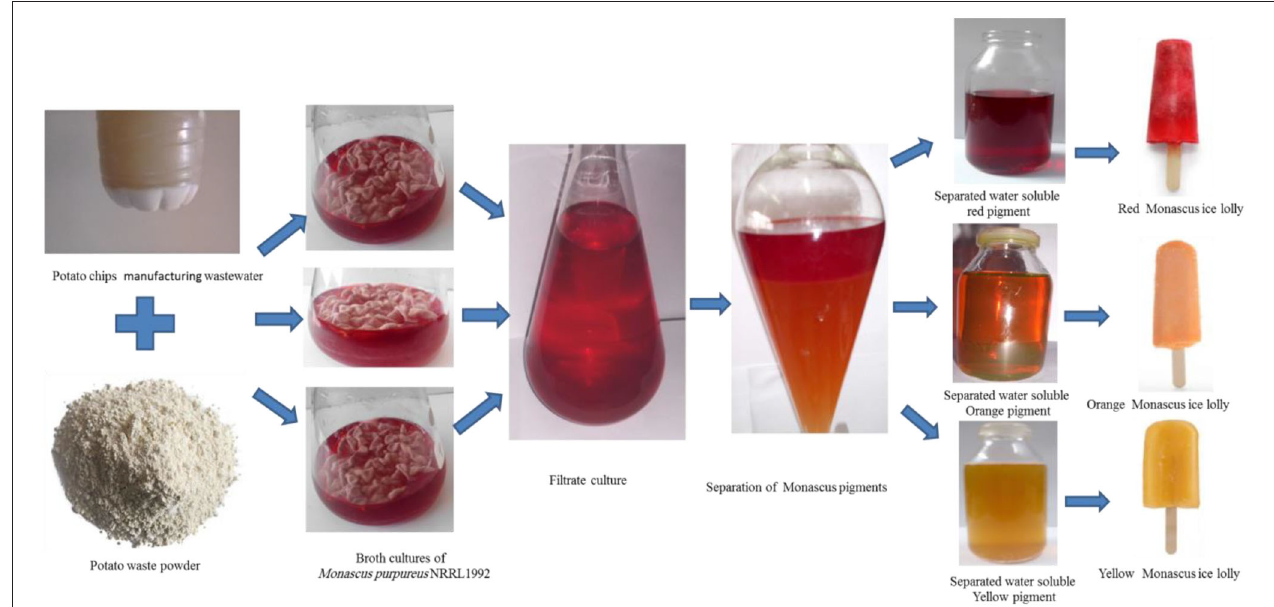
FIGURE 2 | Production and separation of Monascus purpureus NRRL 1992 pigments and their applications in ice